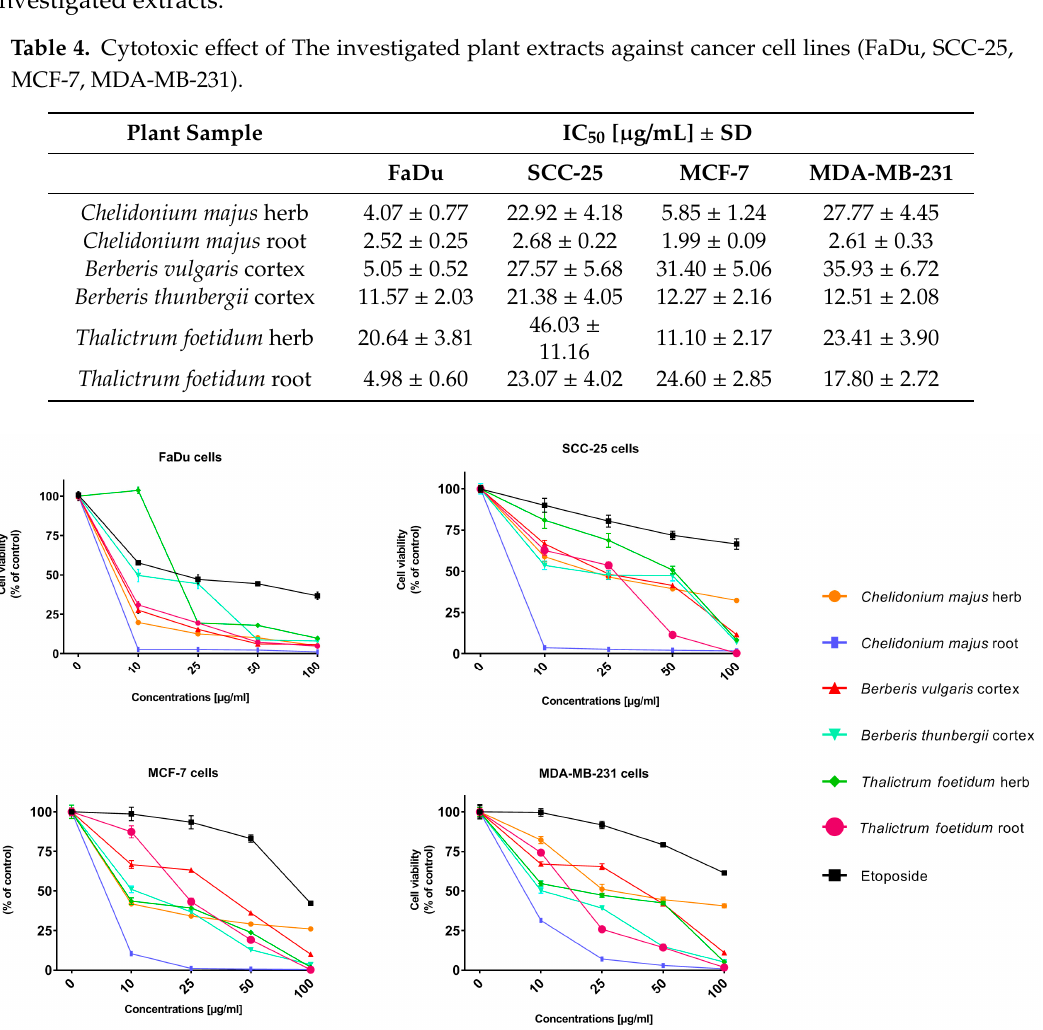
Figure 3. Dependence of human cancer cell viability on concentrations of plant extracts and